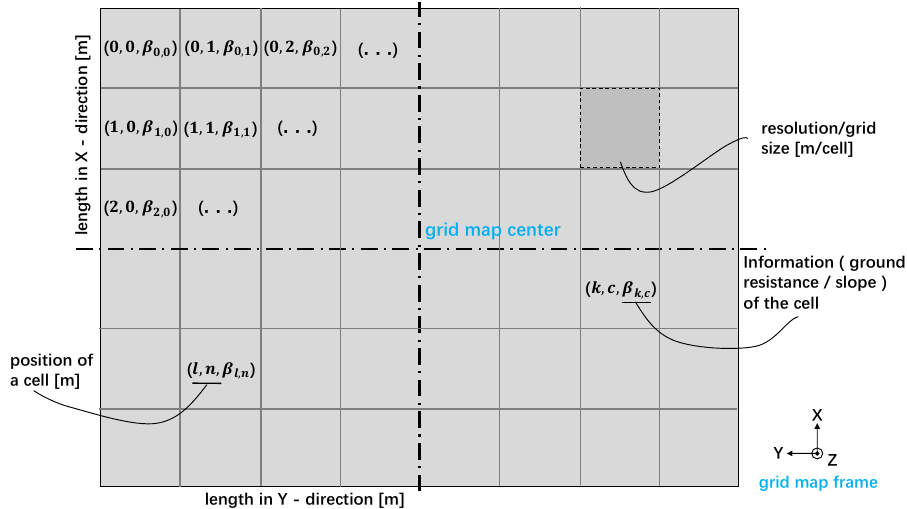
Figure 5. Detail description of a layer in the grid-based